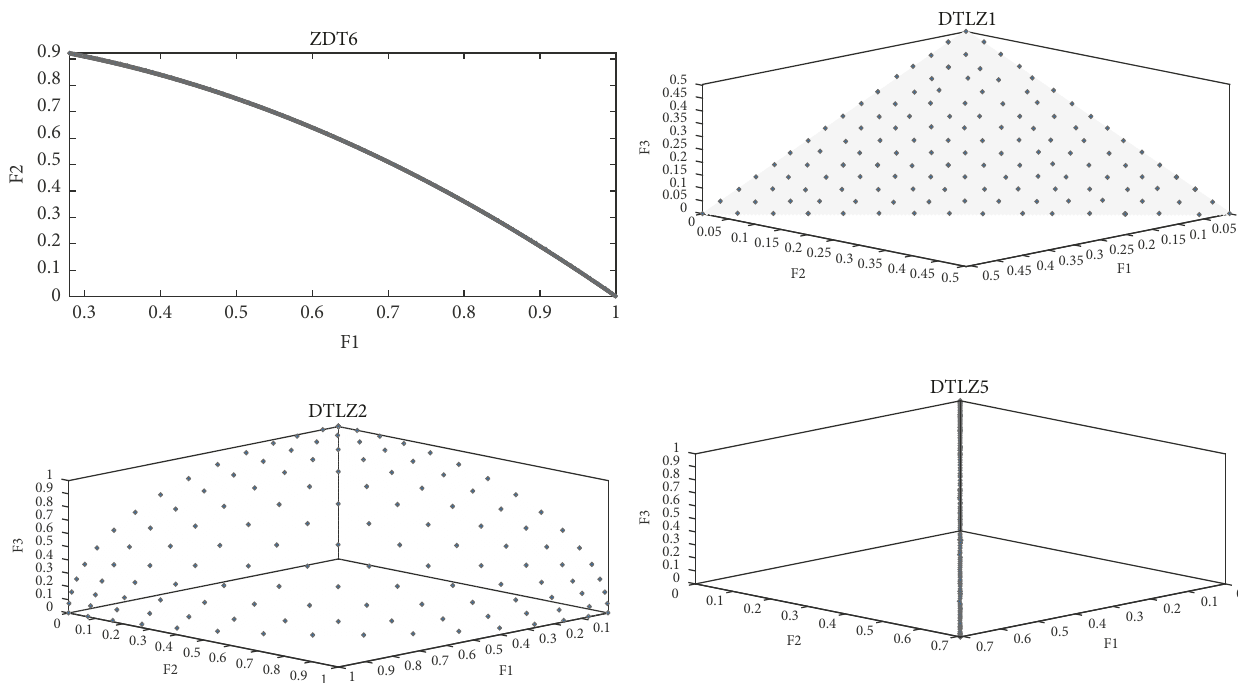
Figure 6: Pareto optimal solutions obtained by LCNSGA-III for ZDT6, DTLZ1-2,